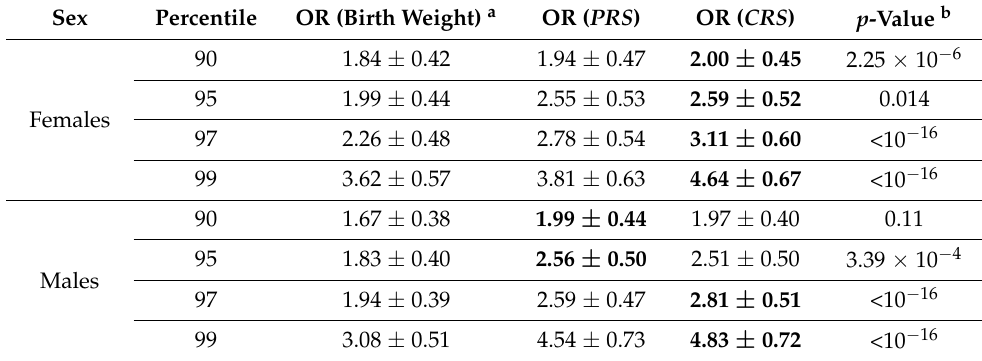
Table 2. Average OR values for T2D for the different measures (birth weight, PRS , CRS ) by percentiles. Sex